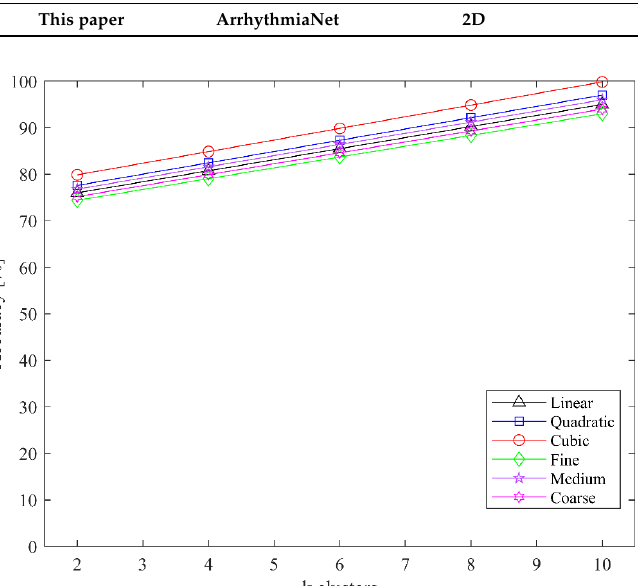
clusters. The classification accuracies of SVM and kNN for different clusters are shown in Figure 8 and Figure 9, respectively.